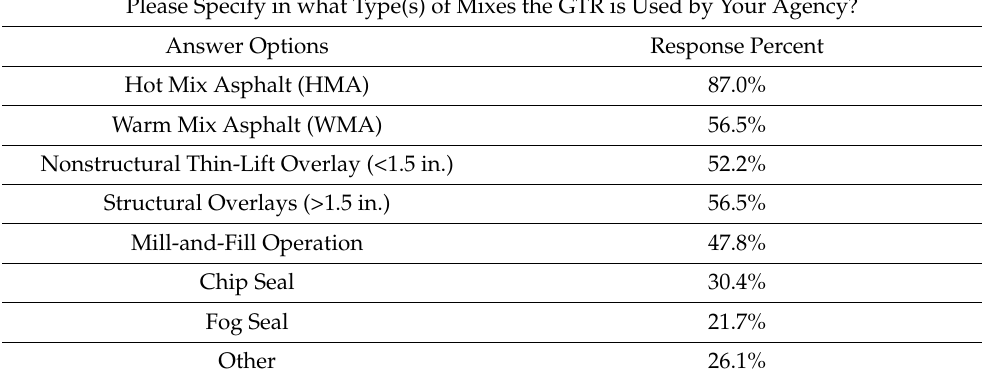
Table 11. Different Applications of GTR in Pavement.